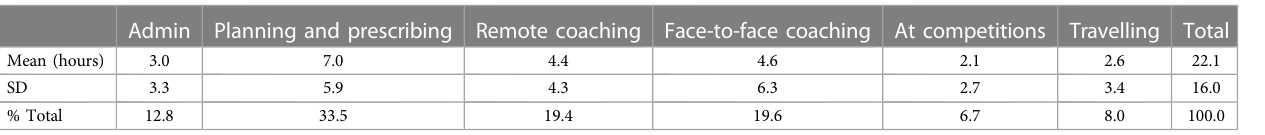
TABLE 4 Proportion of time coaching.